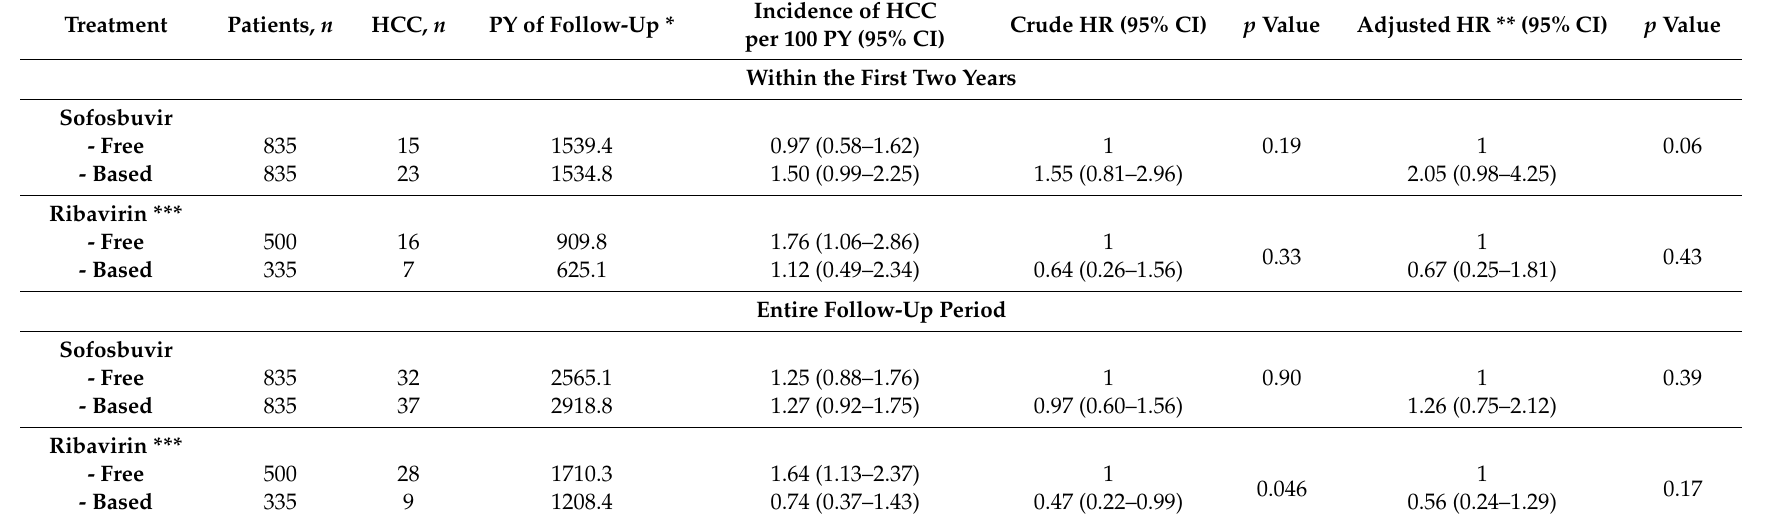
Table 2. Incidence rate of hepatocellular carcinoma, stratified by the use of sofosbuvir or